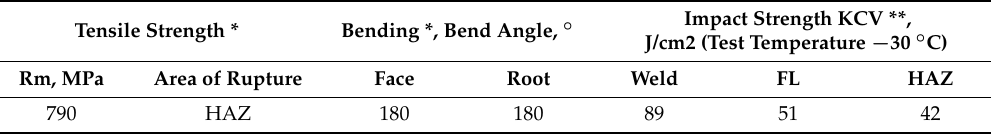
Table 4. Strength and plastic properties of the hybrid weld joint (laser beam-MAG) made of S700MC steel.